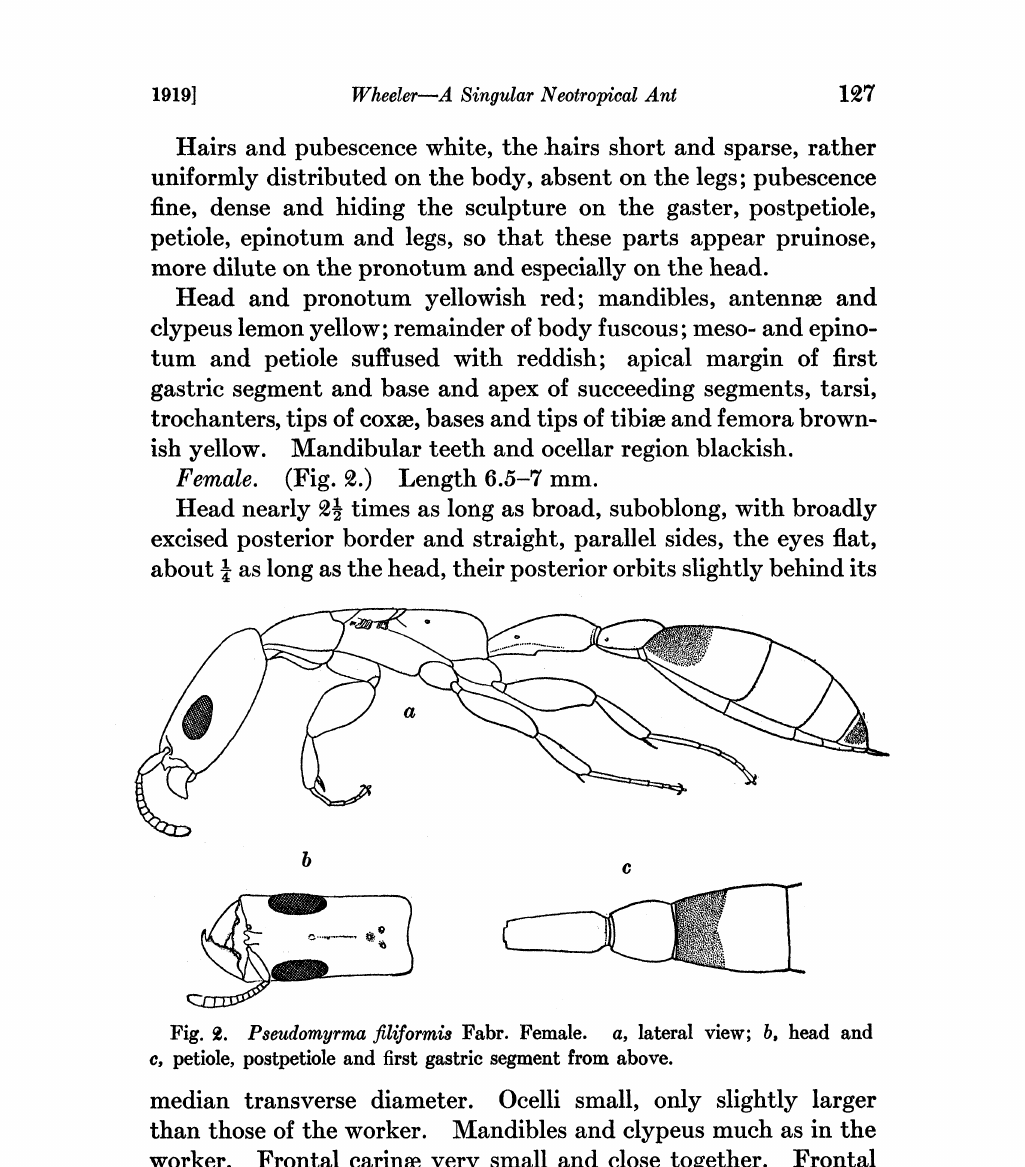
Fig. 2. Pseudomyrma filiformi8 Fabr. Female. a, lateral view; b, head and petiole, postpetiole and first gastric segment from